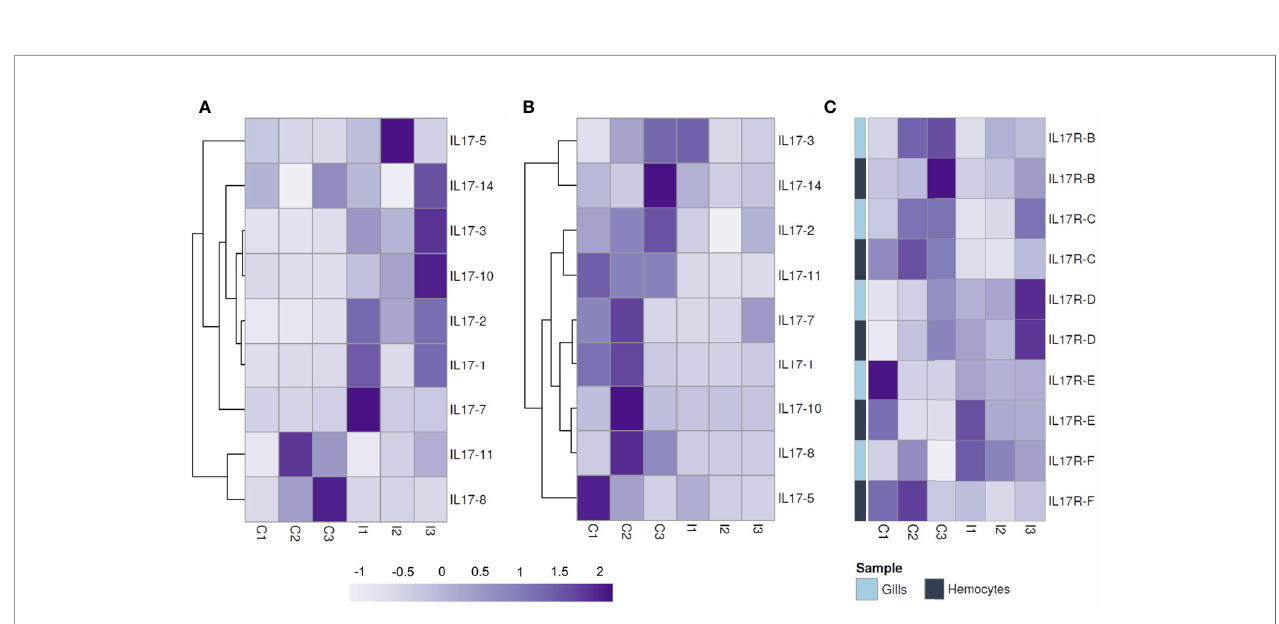
FIGURE 7 | Normalized expression by qPCR of IL-17 isoforms expressed in the gill (A) and in the adductor muscle hemocytes of the same individual mussels (B) after a 24-hour waterborne infection with Vibrio splendidus , as well as the expression of the receptors (C) . In gills, upregulation of the expressed IL-17 isoforms occurred, whereas in hemocytes, there was downregulation. Receptors did not show the antagonistic regulation between hemocytes and gills seen with the IL-17 genes, but instead, the expression of each receptor was correlated in both gill and hemocyte